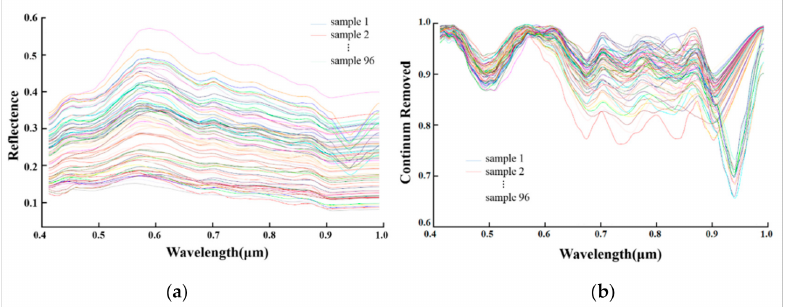
Figure 7. Visible-near-infrared spectral curves, ( a ) original and ( b ) envelope removal spectral